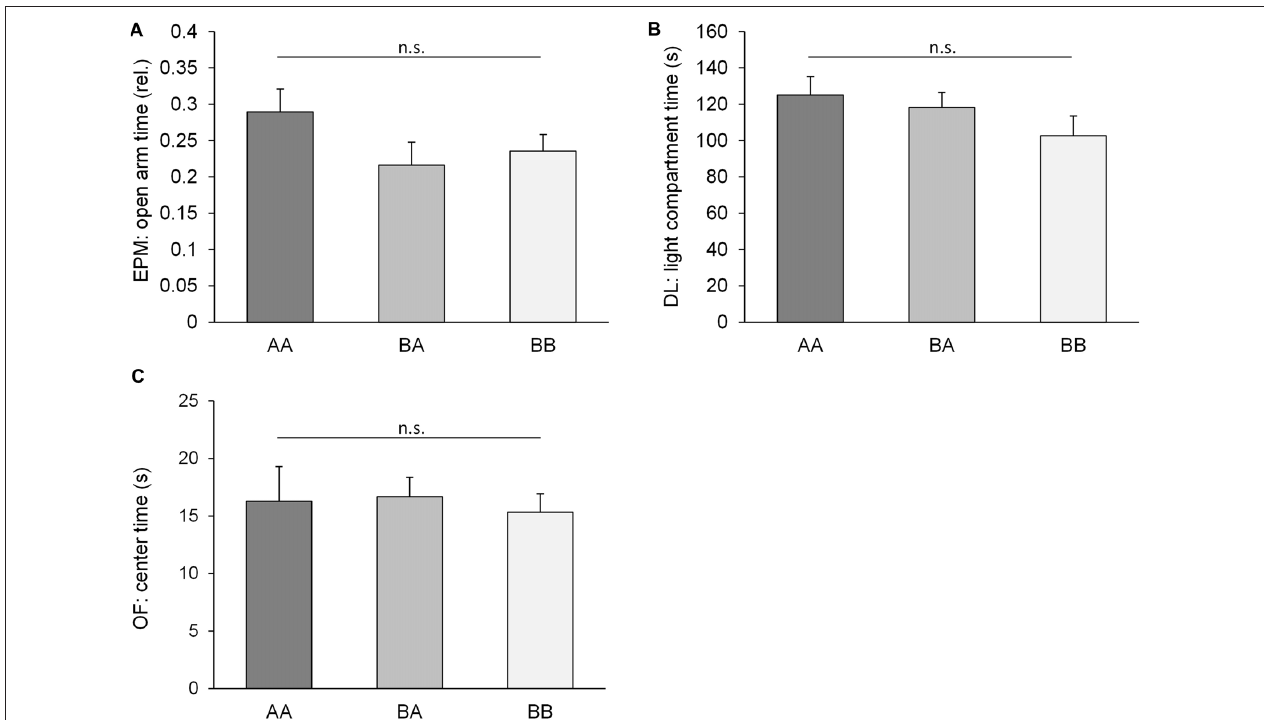
FIGURE 3 | Anxiety-like behavior. Behavioral performance of adult male mice having experienced either benefits followed by escapable adversity (BA group) or throughout adverse (AA) or beneficial conditions (BB), respectively. Data are presented as means + SEM. Statistics: analysis of variance (ANOVA); sample